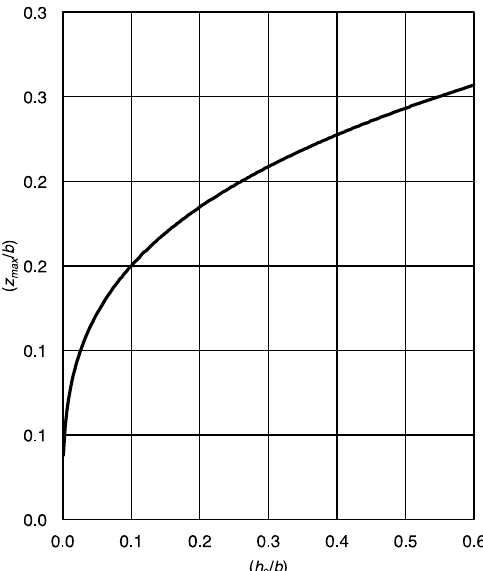
Figure 11. Basic design curve for depth of scour (rectangular piers at zero angle of attack) according to Lausen and Toch [12].